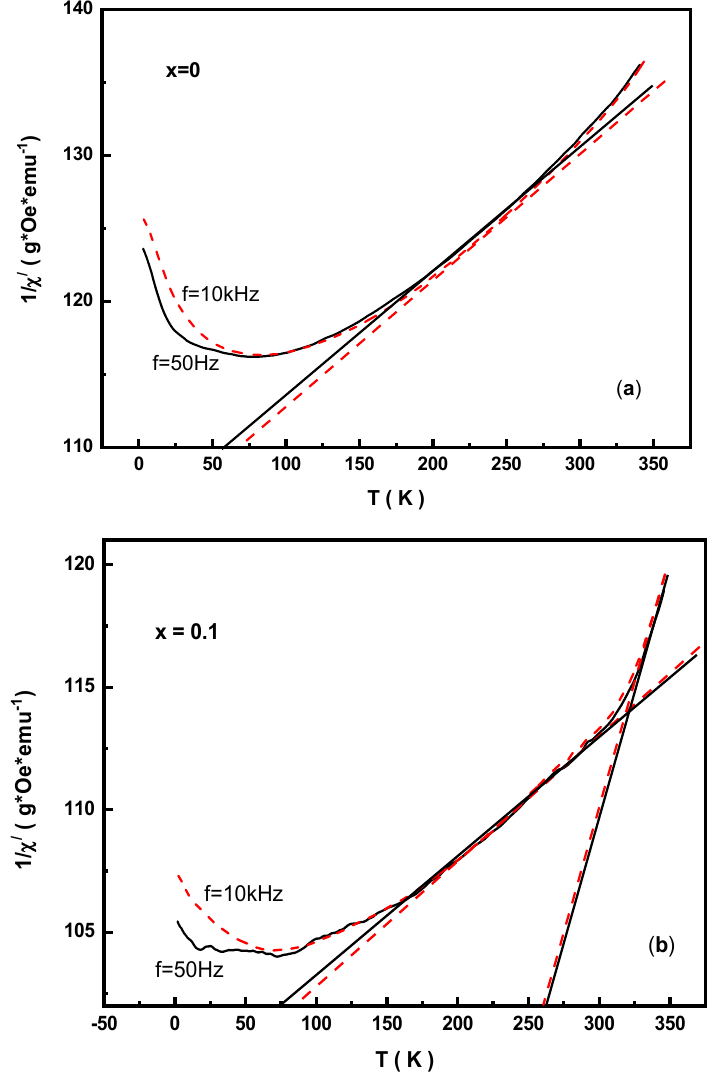
Figure 10. Inverse of real part of the AC susceptibility versus temperature for ( a ) SrFe 12 O 19 and ( b ) Sr 0.9 Mn 0.1 Fe 11.9 Y 0.1 O 19 .